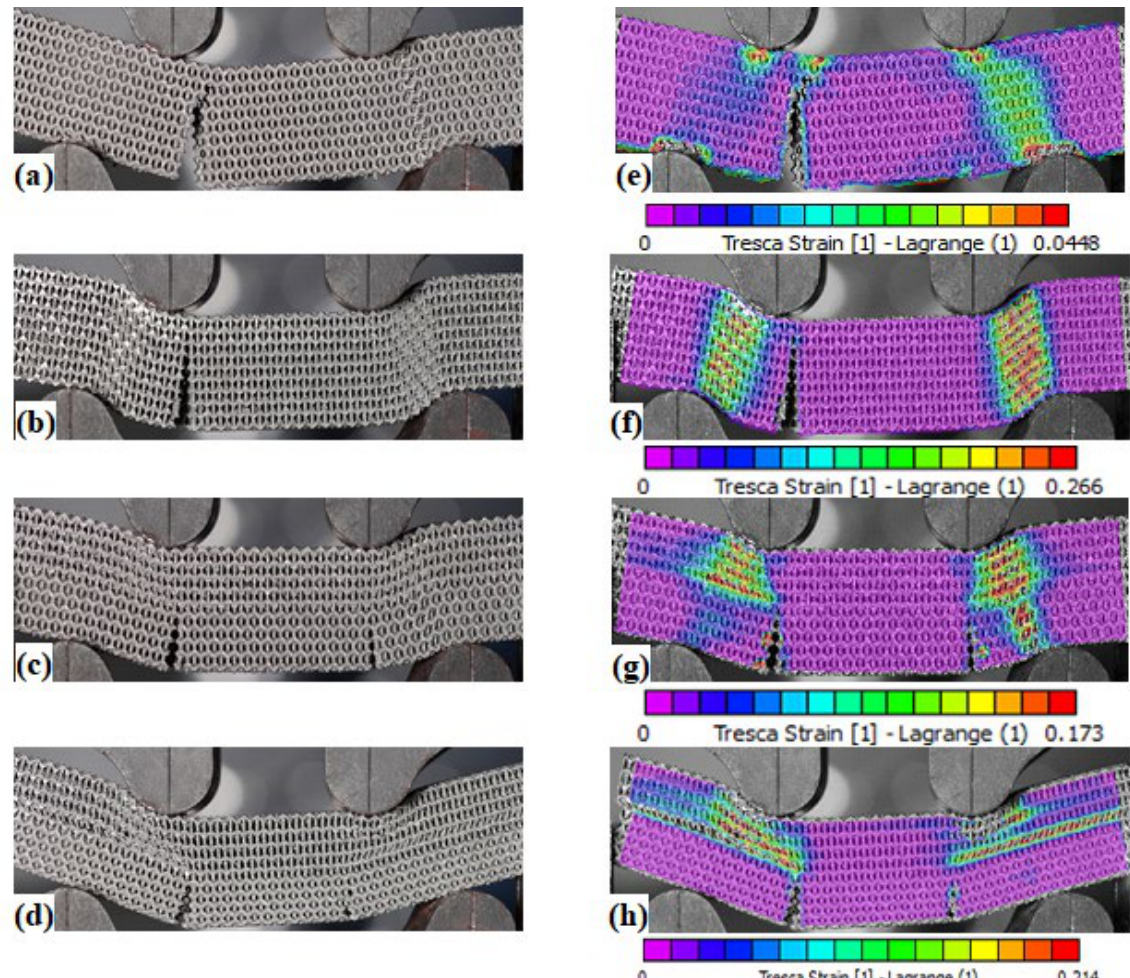
Figure 12. The failure modes of: PPR ( a ); NPR ( b ); HPR ( c ), and FGHPR ( d ) at the onset of final densification, and the strains measured by DIC of: PPR ( e ); NPR ( f ); HPR ( g ) and FGHPR ( h ) at the onset of final densification.